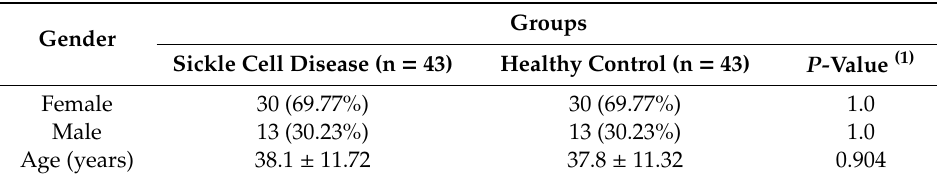
Table 2. Gender and age of patients with sickle cell disease and healthy